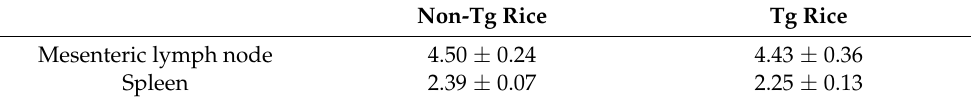
Figure 8. Prophylactic and therapeutic administration with Tg rice expressing Bet v 1 suppresses EAC development. Mice were fed Bet v 1 Tg rice seed or control (non-Tg) rice seed ad libitum for 14 d before the first sensitization (( a , b ) prophy-